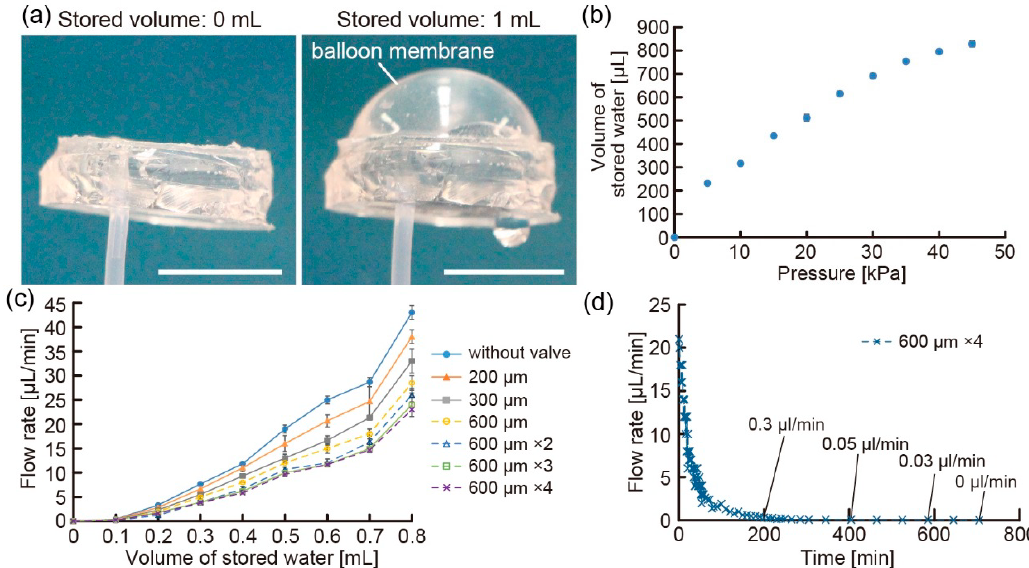
Figure 4. ( a ) Images of the inflation of the balloon membrane when storing water (scale bars: 1 cm); ( b ) relationship between the maximum volume of stored water and the applied input pressure; ( c , d ) plots of the discharge flow rates for different floating valves according to the (c) volume of stored water and ( d ) time after the storage of 0.8 mL of water.